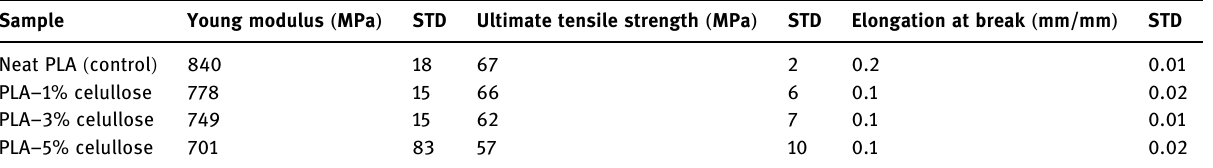
Table 1: Young modulus, tensile strength, and fracture deformation average for each sample